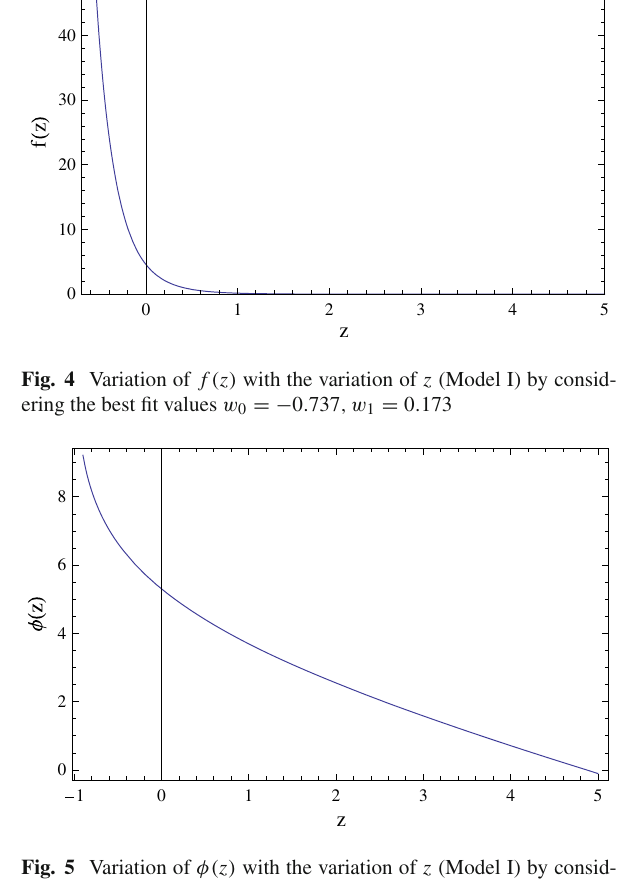
Fig. 5 Variation of φ( z ) with the variation of z (Model I) by consid- ering the best fit values w 0 = − 0 . 737 ,w 1 = 0 .